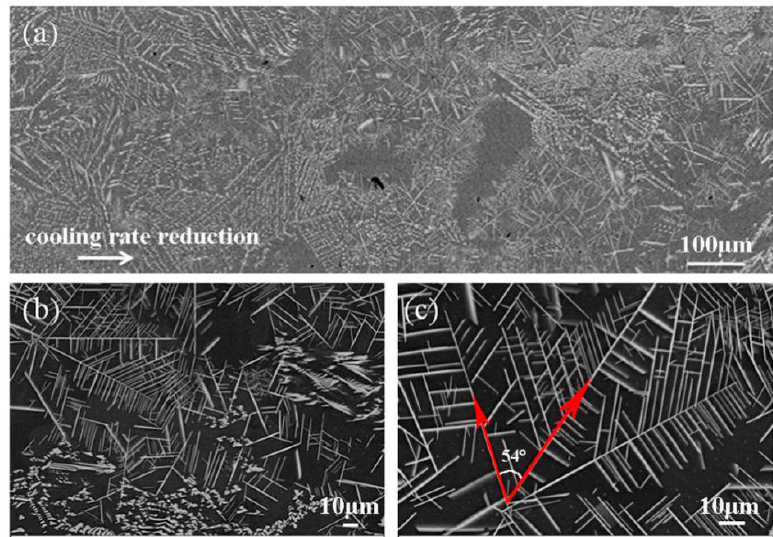
Figure 4. SEM BSE of cross-section of the cylindrical sample in suction casting Al–6 wt.% Mn alloy: ( a ) low magnification; ( b ) high magnification; ( c ) dendrite magnification.